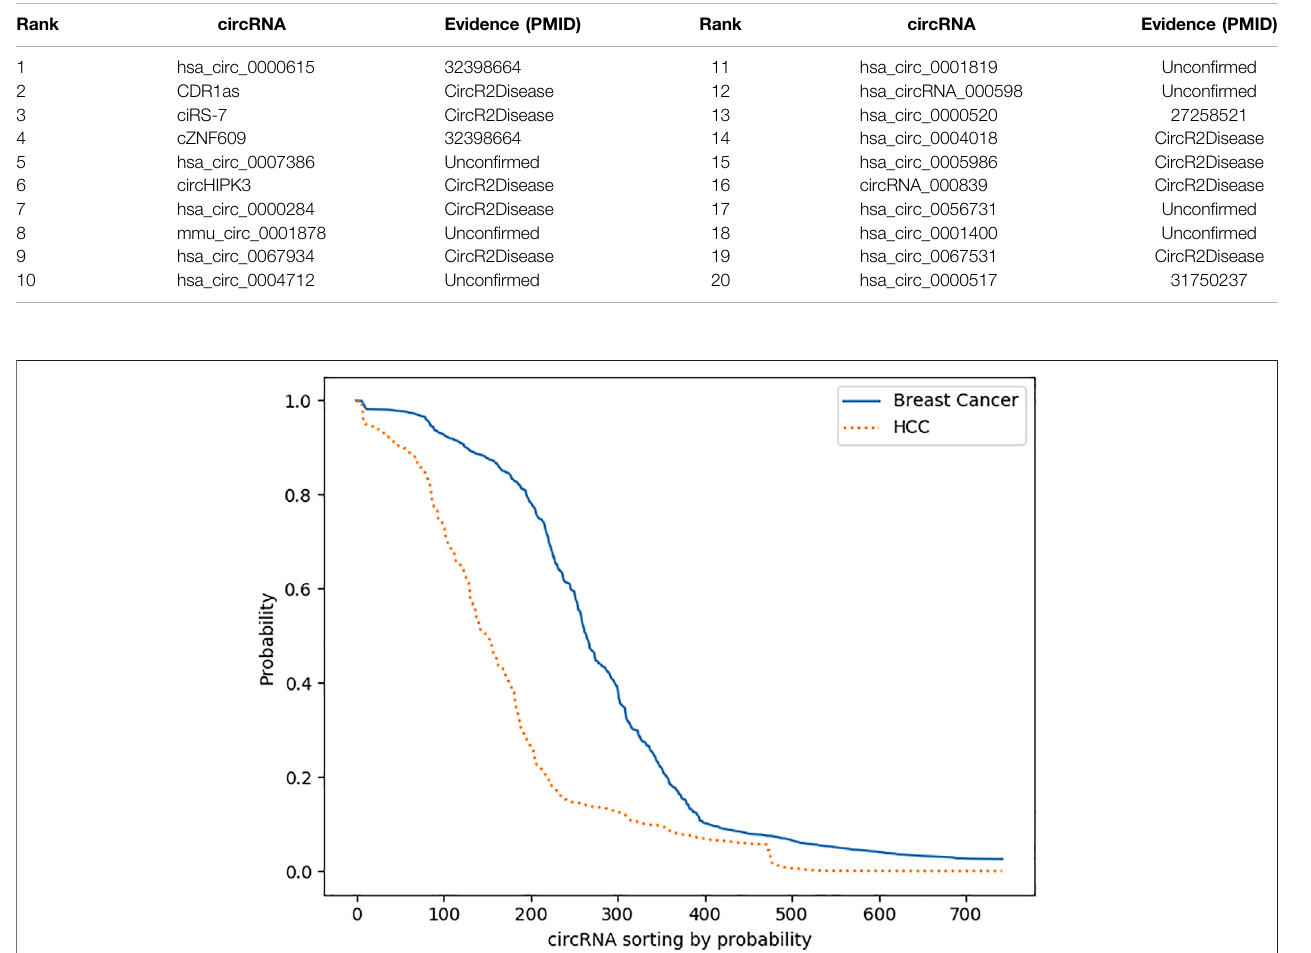
FIGURE5 | Comparison ofpredicted probabilities. Both curves decrease from 0.8 to 0.1signi fi cantly, while the curve of Breast Cancer isabove the curve of HCC.